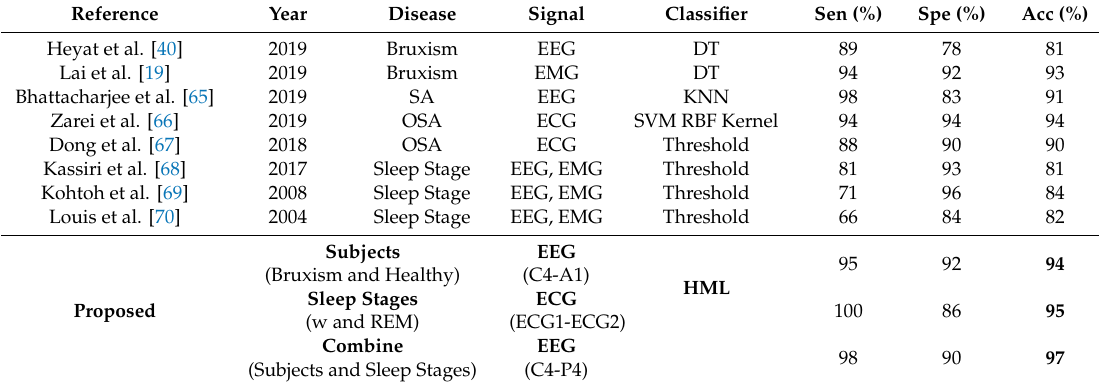
Table 5. Comparison of the proposed method with the existing methods.